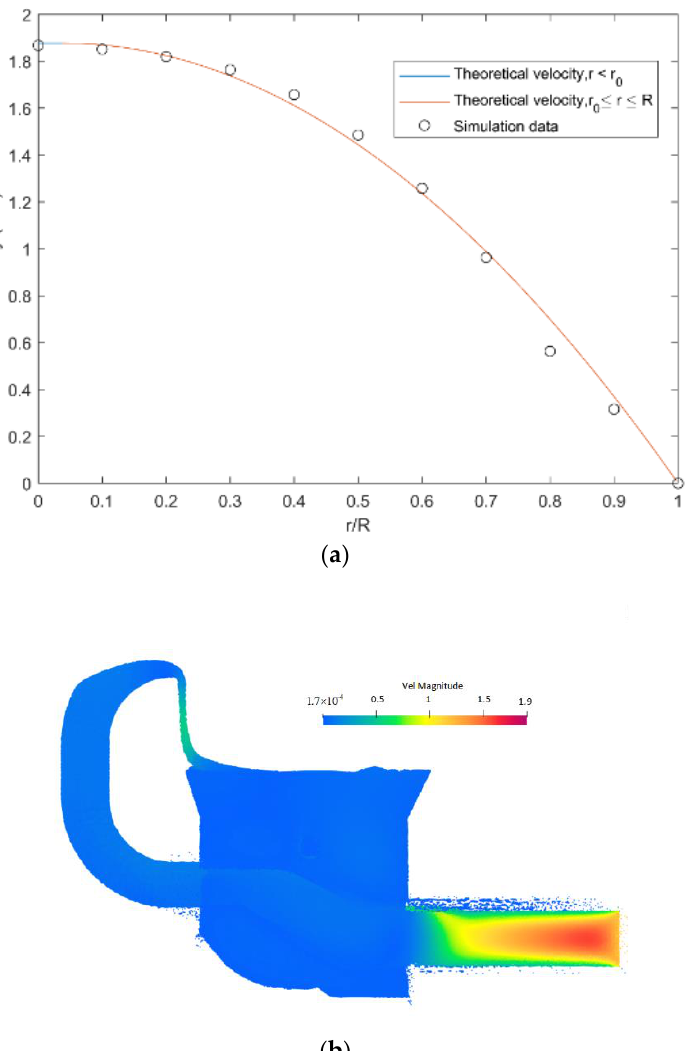
Figure 20. Simulated and analytical velocities of concrete pumping process. ( a ) Analytical laminar velocities. ( b ) Velocity cloud